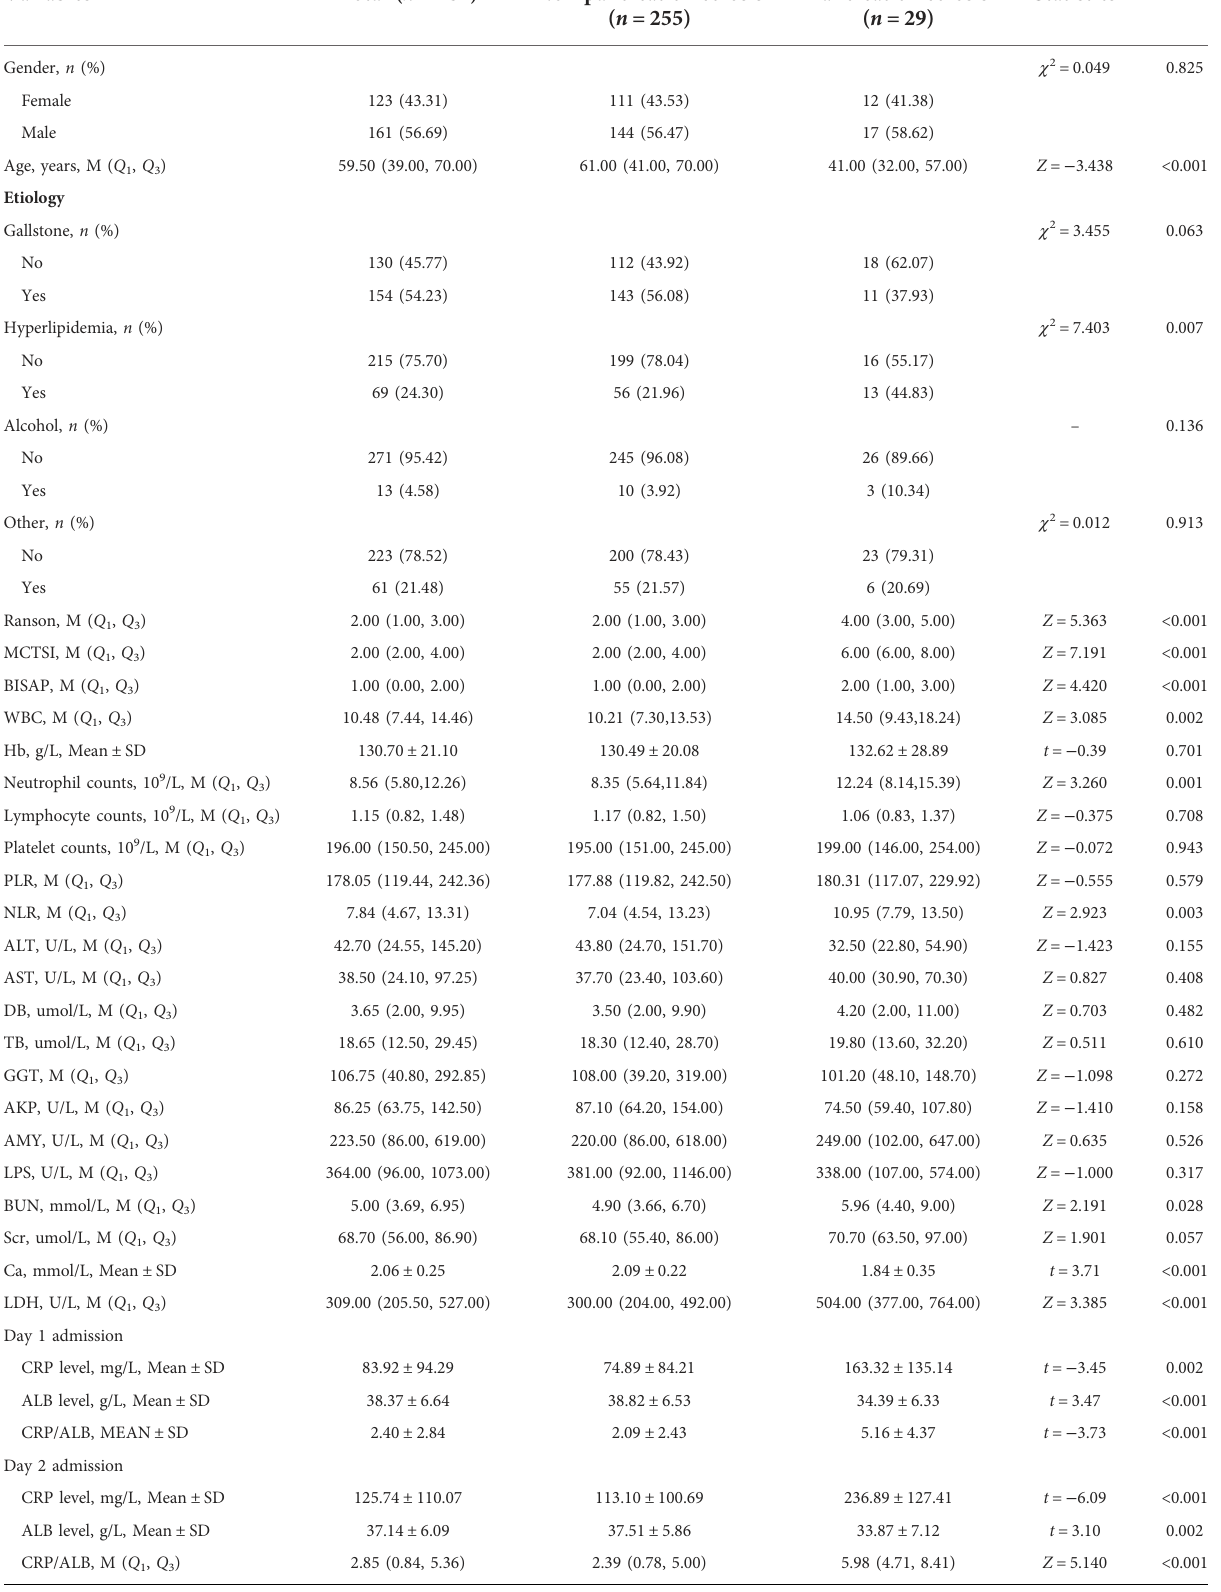
TABLE 3 Differences of population characteristics between patients with and without pancreatic